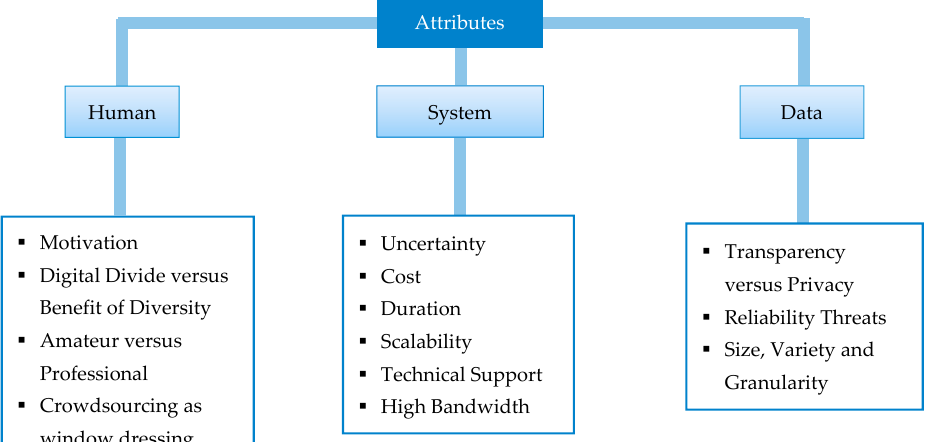
Figure 8. Classification of major attributes: Human, System and Data Characteristics.